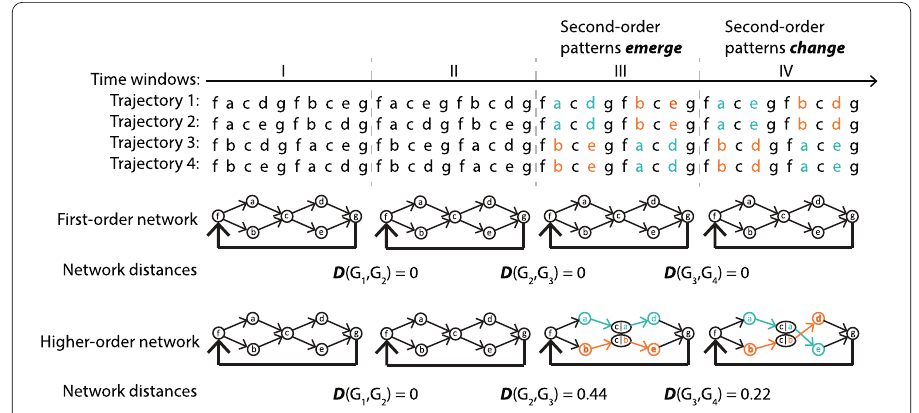
Figure 3 Comparing anomaly detection on taxi trajectories based on the first-order dynamic network and the higher-order dynamic